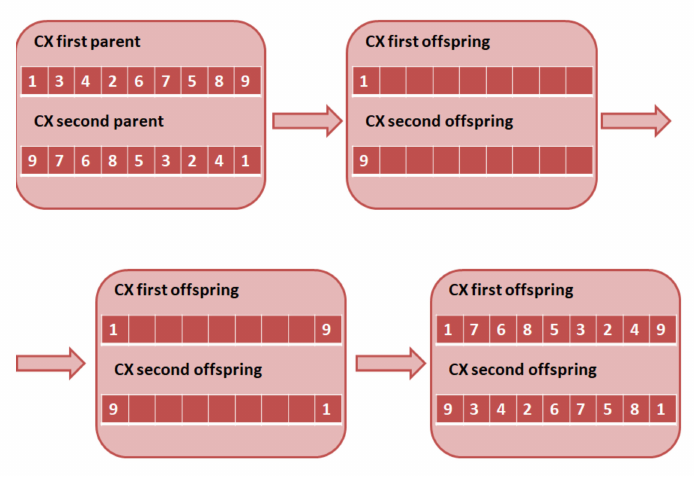
Figure 3. Cycle crossover (CX)